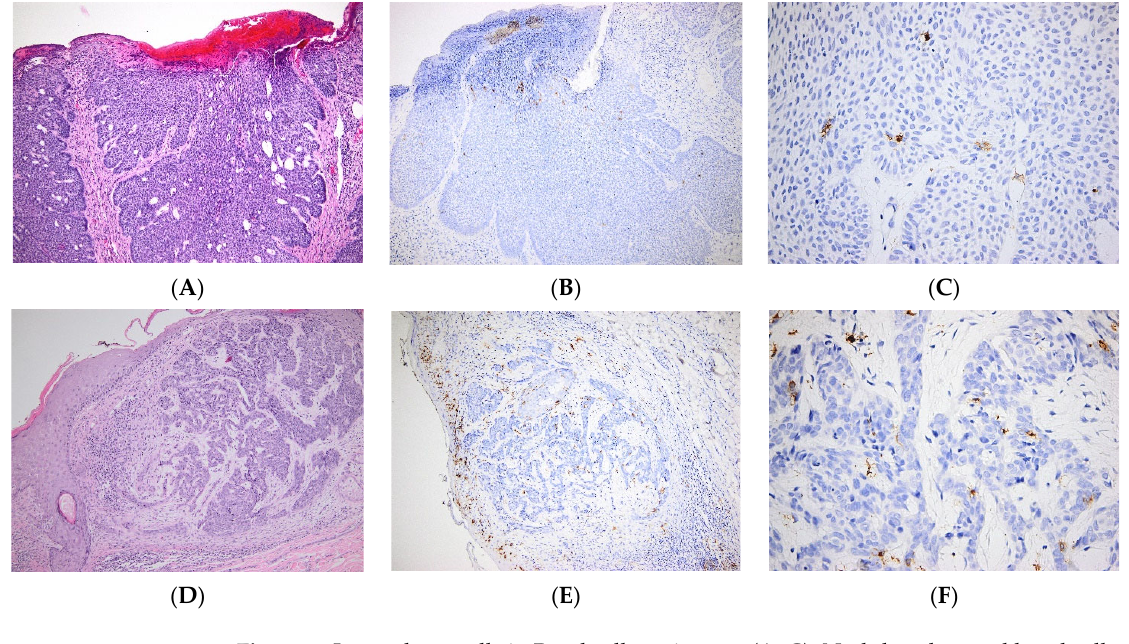
Figure 3. Langerhans cells in Basal cell carcinoma. ( A – C ). Nodular ulcerated basal cell carcinoma. ( A ). Tumor islands of basaloid cells with peripheral palisading. HE × 100. ( B ). Few Langerhans cells within the tumoral mass, most frequent in the superficial area, beneath the necrotic debris. CD1a × 100. ( C ). Very few Langerhans cells within the tumor islands. CD1a × 400. ( D – F ). Infiltrative basal cell carcinoma. ( D ) Cords and trabeculae of basaloid cells. HE × 100. ( E ). Relatively frequent Langerhans cells within the tumoral structures; numerous Langerhans cells within the suprajacent epidermis; small nodular foci of Langerhans cells within the peritumoral inflammatory infiltrate. CD1a × 100. ( F ). Relatively frequent Langerhans cells within the tumor, both intra-tumoral and in tumor stroma. CD1a ×